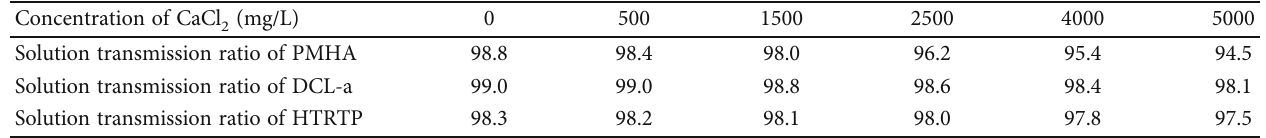
Table 4: Experimental results of antisalting out of PMHA.